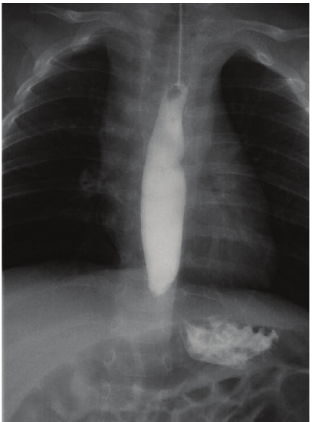
Figure 1: An upper gastrointestinal contrast study revealing an esophageal motility dysfunction. Contrast agent does not flow into the stomach and is seen to pool in the middle to lower esophagus.